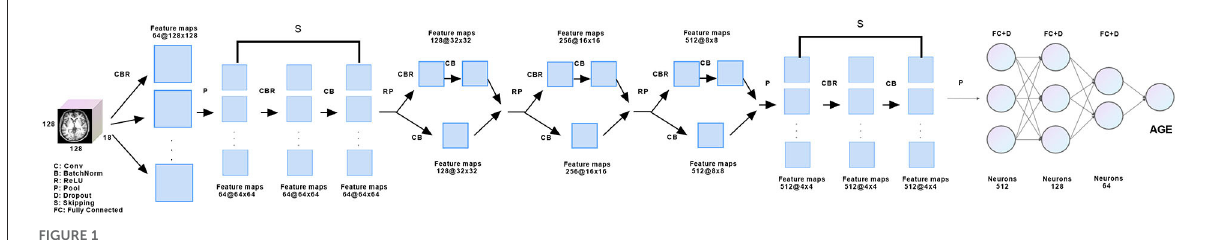
FIGURE1 Model schematic. At the beginning of the model, a 2D convolution layer composed of three convolution kernels was used for feature extraction, followed by a skipping layer composed of nine skipping blocks to capture deeper features. Features were learned again through three groups of convolution layers designed by reference GoogLeNET, and the same skipping layer was used to capture deeper features. Finally, the brain age was regressed through the full connection layer.